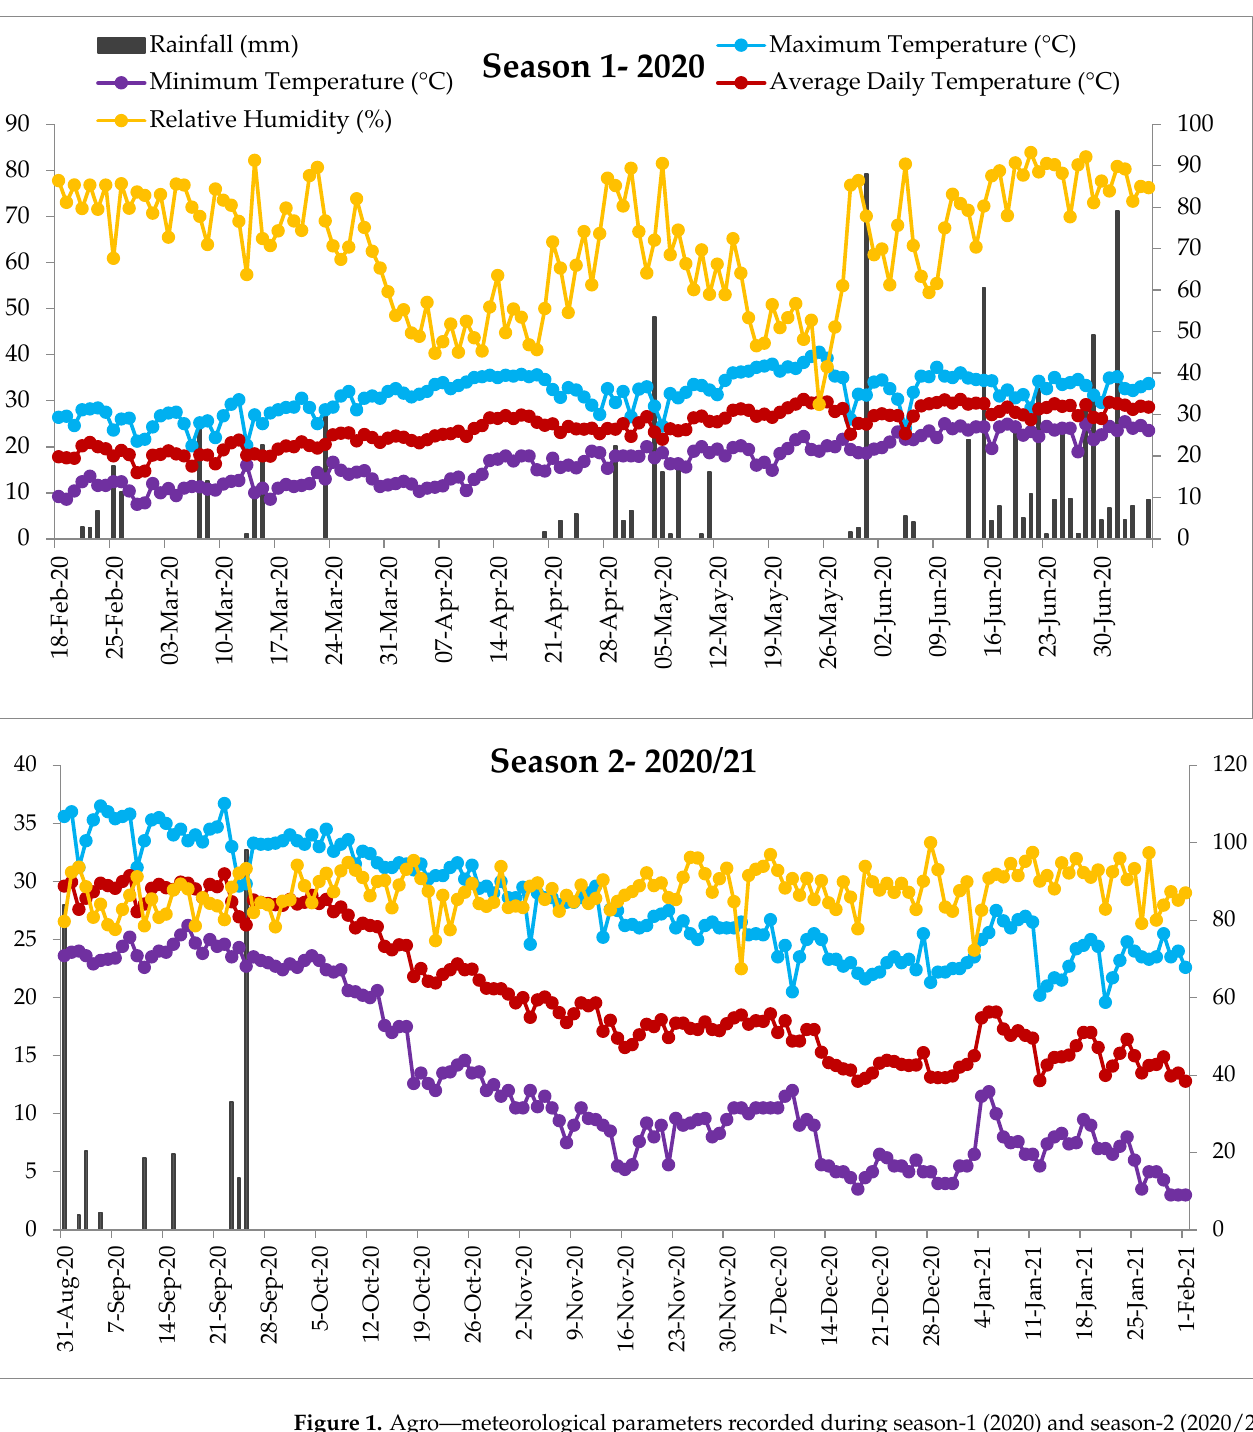
Figure 1: Agro- meteorological parameters recorded during season 1- 2020 and season 2- 2020/21. Daily rainfall (bar, black), minimum (purple line with markers), average (dark red line with markers) and maximum temperature (light- blue line with markers) are represented in primary vertical axis whereas relative humidity (orange line with markers) is represented through secondary vertical axis. Date is presented in day-month- year format where tail digit 20 (as in 1-Sep-20) and 21 (as in 26-Jan-21) indicates years 2020 and 2021 respectively. The meteorological data was obtained from nearest meteorological station (Mehelkuna site) of office of hydrology and meteorology.